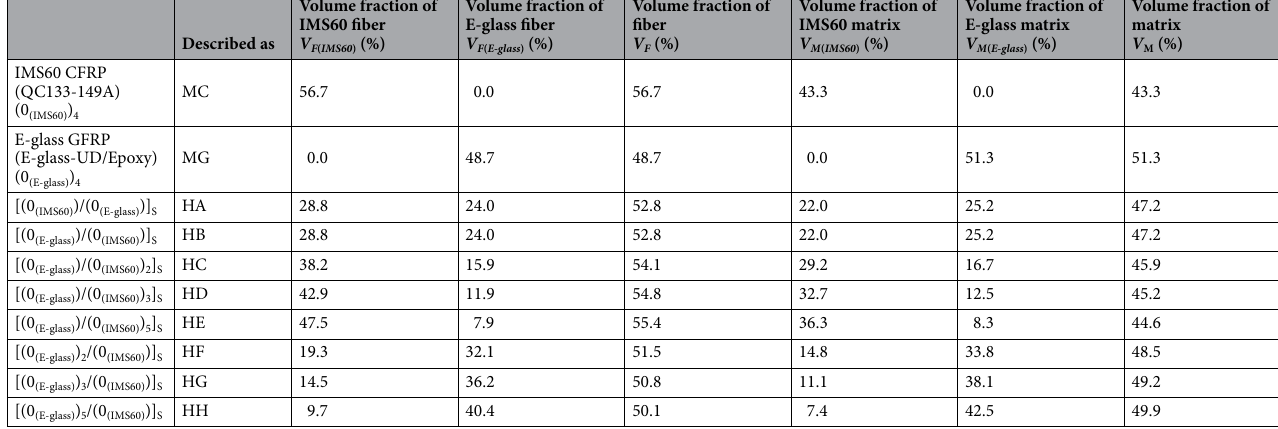
Table 1. Volume fraction of elements for the mono CFRP and GFRP, and HFRP